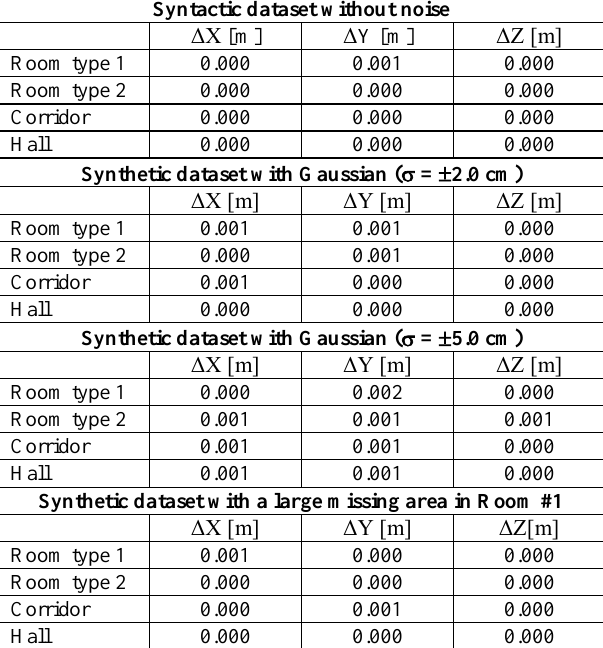
Table 1. Comparison between room center coordinates as detected by the proposed method and ground truth for the performed tests.